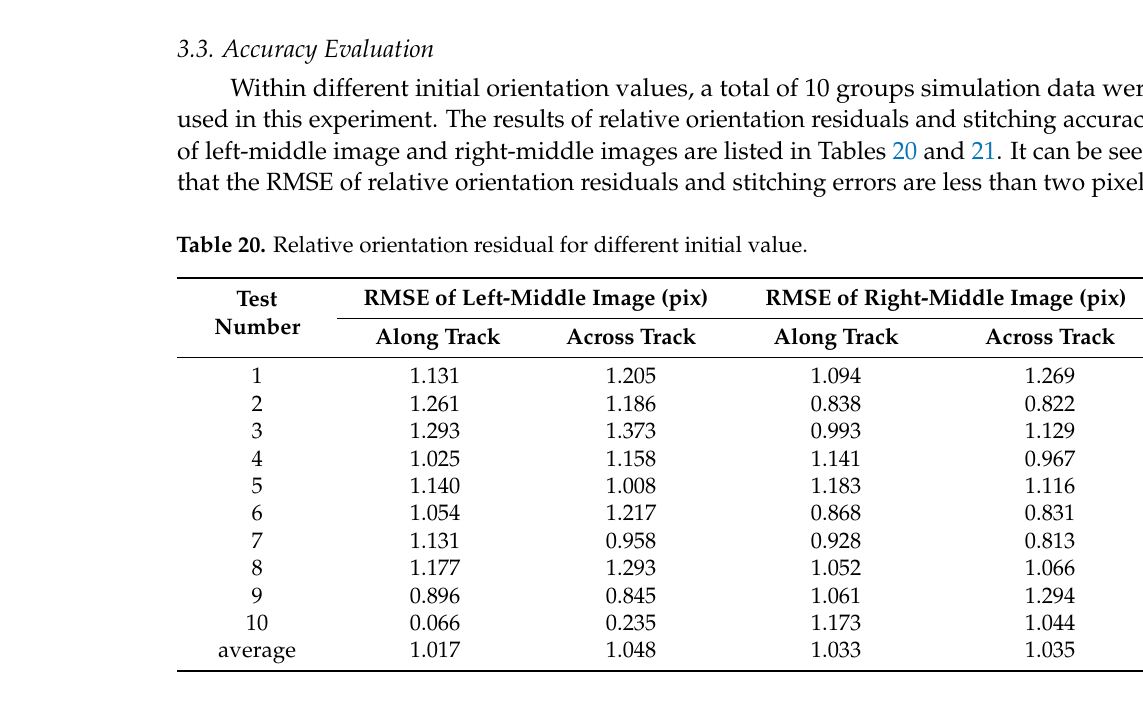
Table 21. Stitching error for different initial